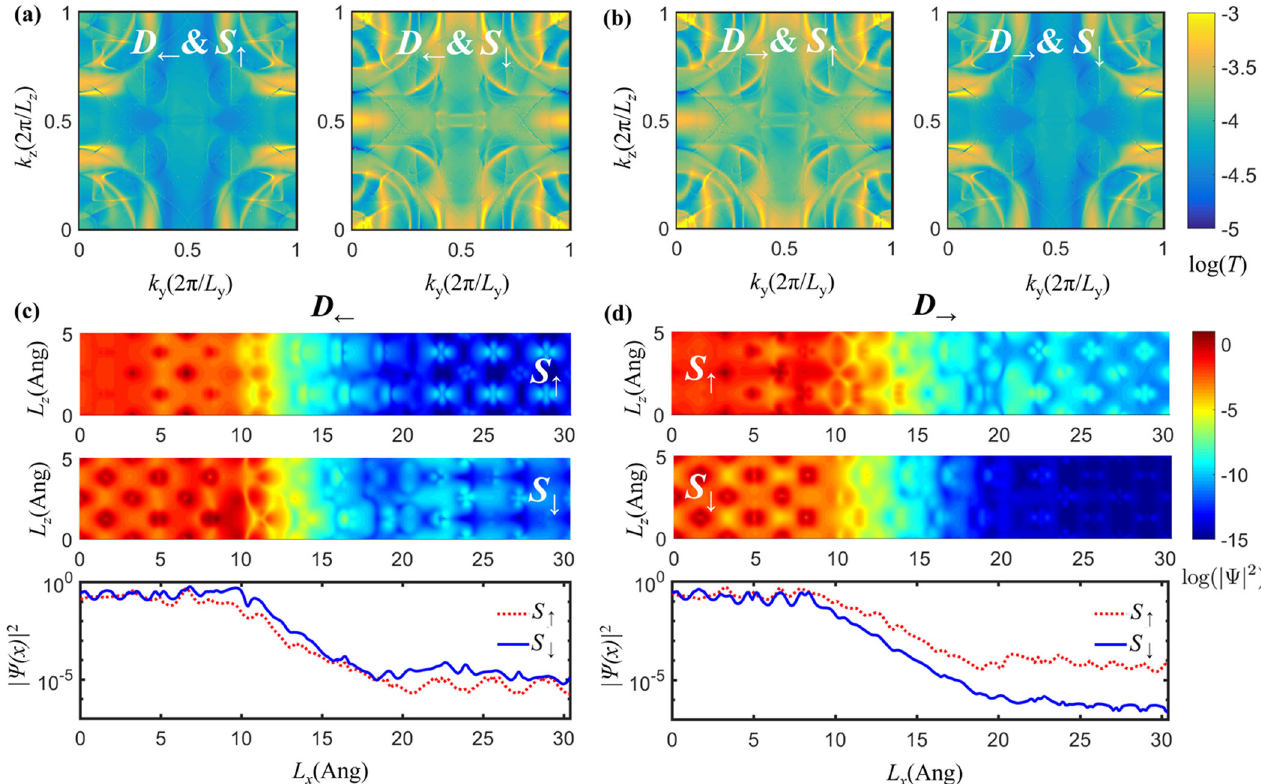
Fig. 5 Spin dependent transmission maps, spin scattering states of the Co/HfO 2 /Co junction with Hf-terminated interfaces. Spin dependent transmission maps in the 2D Brillouin zone of the Co/HfO 2 /Co junction with Hf-terminated interfaces at an antiparallel state at the Fermi level E = 0 eV: ( a ) D ← and ( b ) D → . S ↑ ( S ↓ ) indicates spin-up (spin-down) state. Real space distribution of spin scattering states Ψ x ; z ð Þj j 2 and projected distribution of spin scattering states Ψ x ð Þj j 2 at k t = ( k y , k z ) = (0, 0): ( c ) D ← and ( d ) D → E F = 0 eV in Fig. 5. Figure 5a, b shows the transverse wave vector k t = ( k y , k z ) resolved transmission for spin-up and spin-down states at the Fermi level E F = 0 eV in the 2D Brillouin zone for two ferroelectric polarization orientations. It can be directly found that there are more spin-down tunnel channels at D ← in Fig. 5a. With the reversal of ferroelectric polarization, there are more pro- nounced spin-up tunnel channels in Fig. 5b. Figure 5c, d plots spin scattering states in real space at k t = ( k y , k z ) = (0, 0). Scattering states are eigenstates of the device structure 61 , which come from the left lead, tunnel through the insulator layer, and transmit into the right lead. Injected spin scattering states are the same and decay exponentially through the HfO 2 barrier for both FE polarization states as shown in Fig. 5c, d. It can be found that there is a longer decay length for the spin-up state at D ← in Fig. 5c, while spin-down incoming states decay faster than spin-up states at D → in Fig. 5d. Therefore, spin polarization directions of out-coming scattering states are different due to the different interfacial properties: spin-down polarized at D ← and spin-up polarized at D → . All these results manifest that generation and manipulation of spin current are realized in the proposed MFTJs. In the proposed devices, the spin-polarized current is generated and switched by manipulating spin-dependent tunneling barriers due to interfacial magnetoelectric coupling. Therefore, it is critical to induce strong magnetoelectric coupling at interfaces to realize a high spin polarization. So, we study device structures with Hf atoms on top of Co atoms (see Supplementary Fig. 2a). The spin polarization ratio can be as high as − 94% at D ← and is switched to 94% at D → (see Supplementary Fig. 2b), which manifests that the spin polarization properties of the proposed devices can be optimized by interfacial engineering.